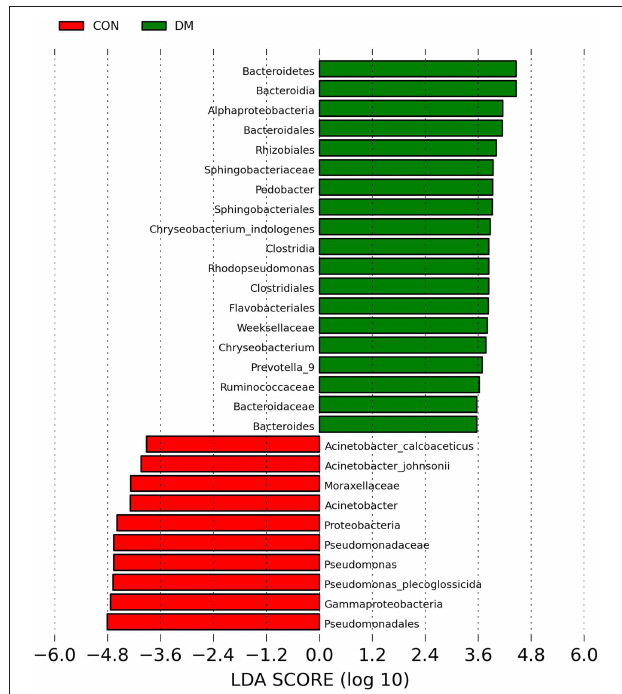
FIGURE 4 | Taxa listed according to their linear discriminant analysis (LDA) values determined from comparisons between DM patients and healthy subjects using the LEfSe